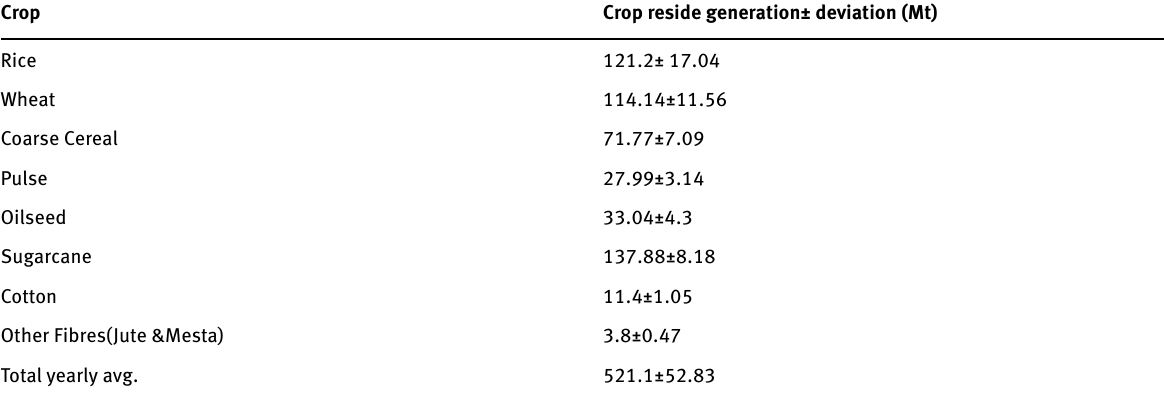
Table 3: Yearly average crop residue generation in India with combined uncertainty 2010-14